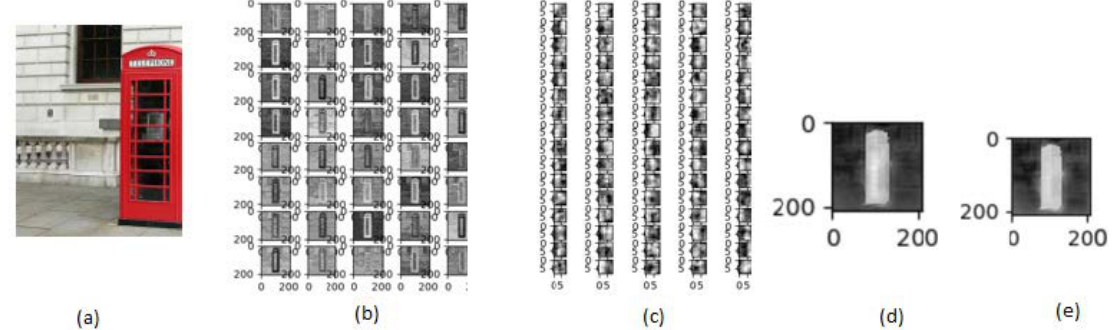
Figure 4. Output of various components of proposed approach: ( a ) input image, ( b ) local feature map, ( c ) global feature map, ( d ) predicted saliency map, and ( e ) refined saliency map.